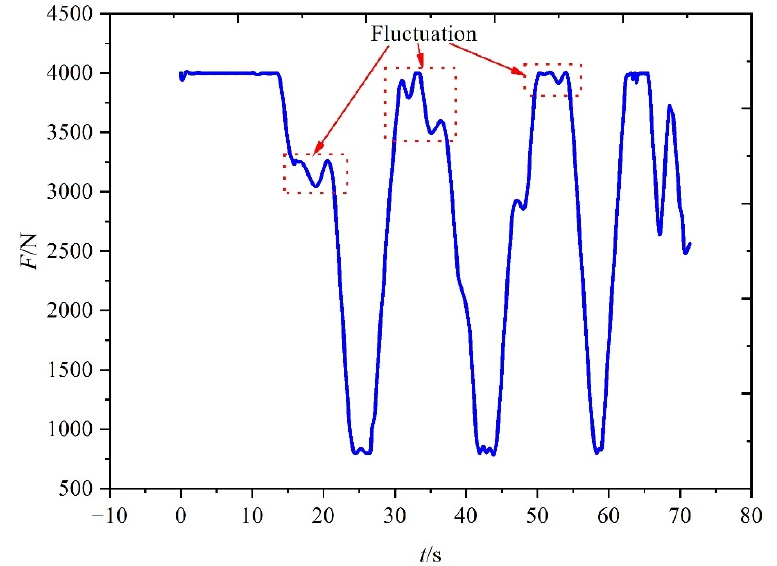
Figure 15. Thrust under case 1 in the third scenario vs. time.